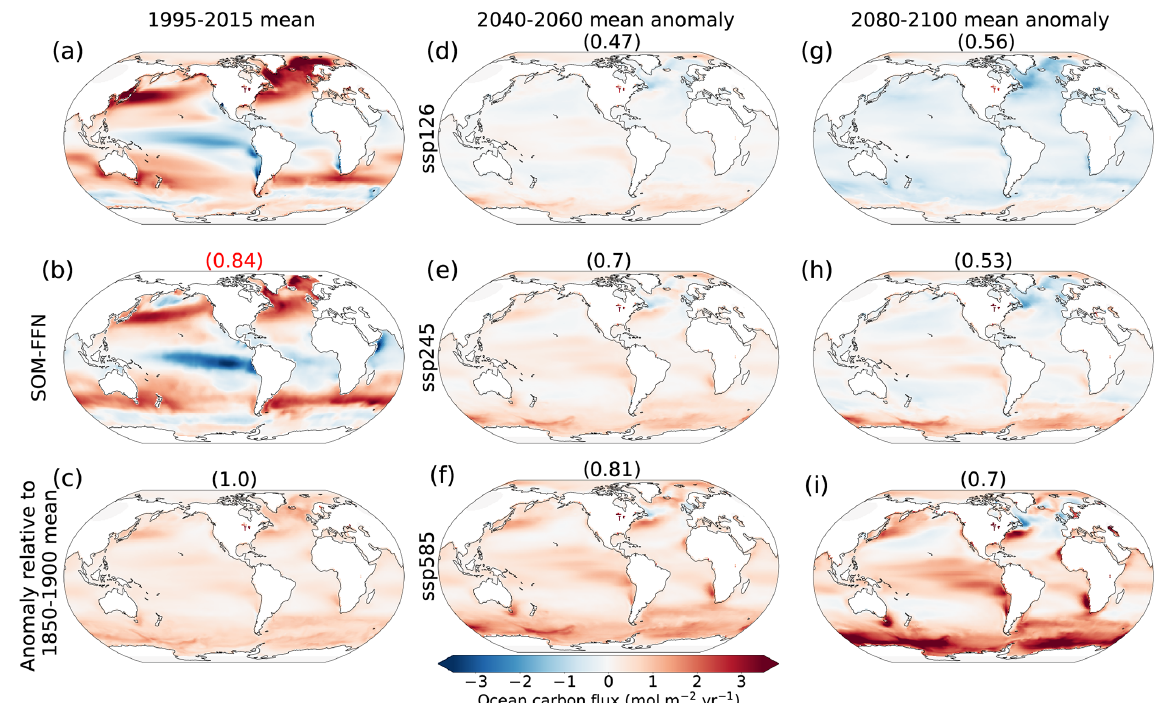
Figure 1. CMIP6 multi-model mean maps of carbon sink and sink anomalies using one realization of each model. Columns represent different time periods: the recent time (1995–2015 mean), mid-century (2040–2060 mean), and late century (2080–2100 mean). Note: the sink is positive into the ocean. The first column shows (a) the CMIP6 ensemble mean air–sea CO 2 flux over 1995–2015, (b) the Landschützer et al. (2016) SOM-FFN product, and (c) the CMIP6 ensemble mean flux anomaly over 1995–2015 relative to the 1850–1900 mean. Other panels are anomalies relative to the 1995–2015 multi-model mean (a) . Panels (d) through (i) show different scenarios. Numbers above each map are correlation coefficients between the absolute value of the change relative to 1995–2015 with the 1995–2015 anomaly map relative to the pre-industrial era in (c) , except the red number at the top of (b) , which is the correlation coefficient with this panel and (a)